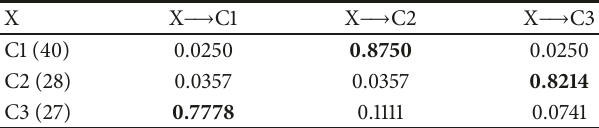
Table 4: The number of nodes in each cluster and the ratio of the numberofedgesbetweenclustersorinsidetheclustertothenumber of nodes in the cluster in Gnutella network with 4.6% of initial number of nodes in all